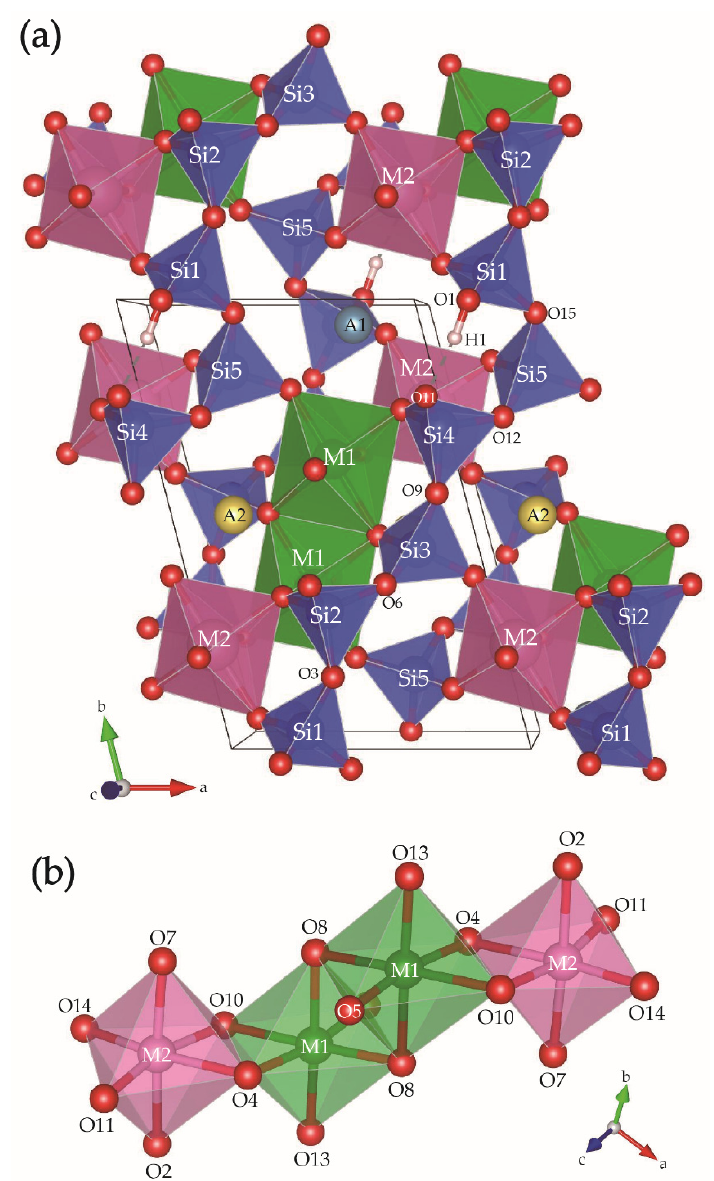
Figure 3. The crystal structure of Sc-rich babingtonite ( a ) and the topology of octahedra ( b ) drawn with VESTA3 [26]. Table 5. Cation distribution and estimated bond distances at the M1 and M2 sites.